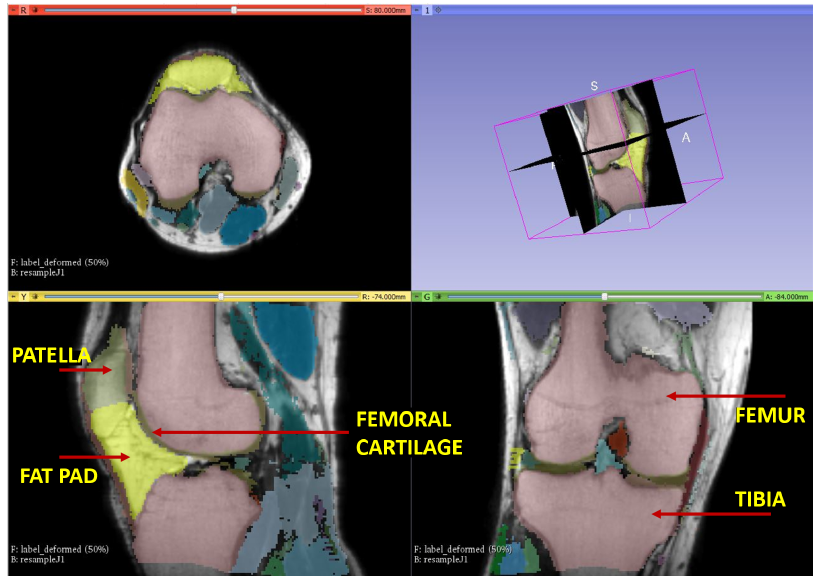
Figure 3. Coronal, axial, sagittal views of the segmentations obtained from knee MRI using de- formable